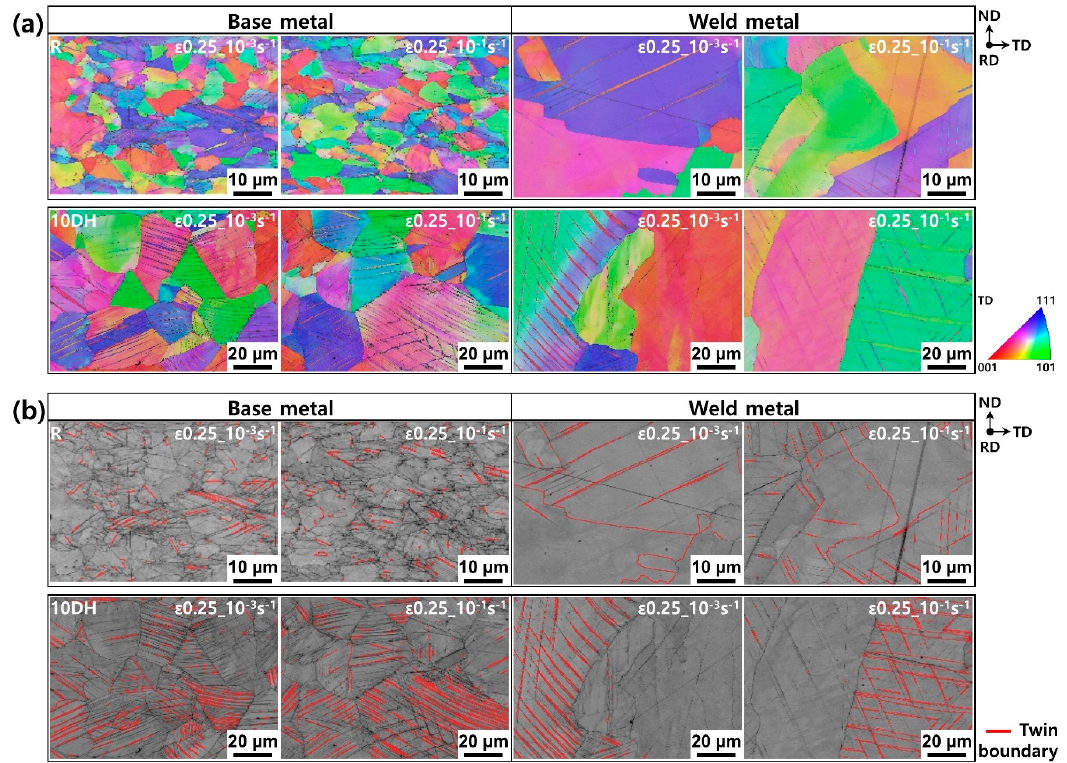
Figure 10. RD invers pole figure (RD-IPF) maps of the base metal and weld metal in pipes R and 10DH: ( a ) RD-IPF map and ( b ) twin boundary maps.